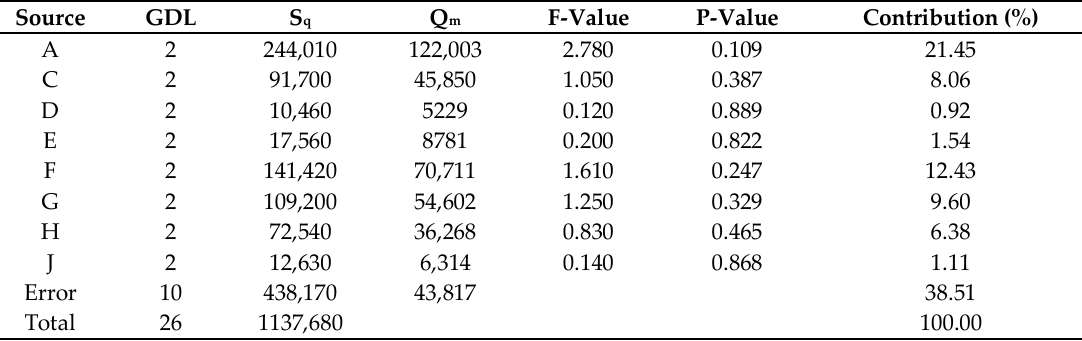
Table 3. ANOVA analysis for bead width.